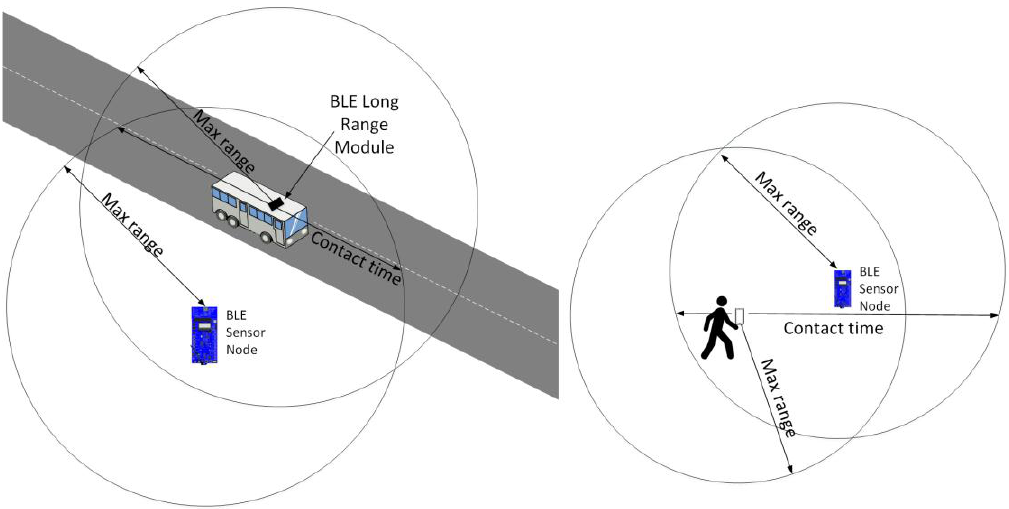
Figure 1. Illustration of OSDC concept examples, where the mobile entity is a bus ( Left ) or a pedestrian ( Right ). The mobile entity is equipped with a BLE device and collects data from the sensor node during the contact time.